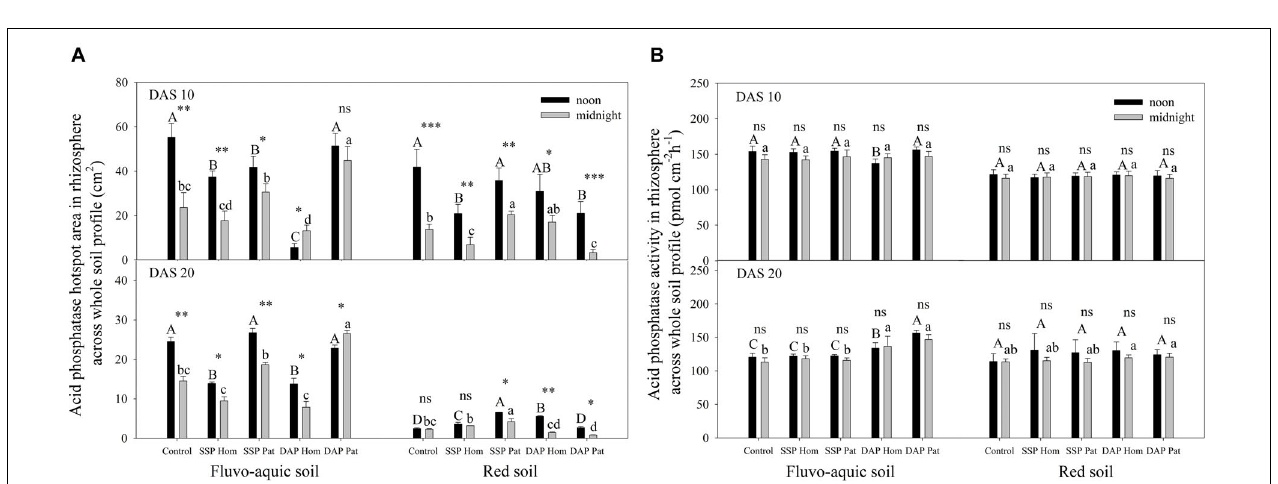
FIGURE 7 | The hotspot area (A) and mean activity (B) of acid phosphatase in rhizosphere across whole soil profile on 10 DAS and 20 DAS in fluvo-aquic soil and red soil. Capital letters indicate significant differences between fertilization treatments on noon, lower-case letters indicate significant differences between fertilization treatments at midnight, and asterisks indicate significant differences between noon and midnight in the same rhizobox (significance level: ∗ P < 0.05; ∗∗ P < 0.01; ∗∗∗ P < 0.001; ns, no significant). Each column refers to the mean values of four replicates